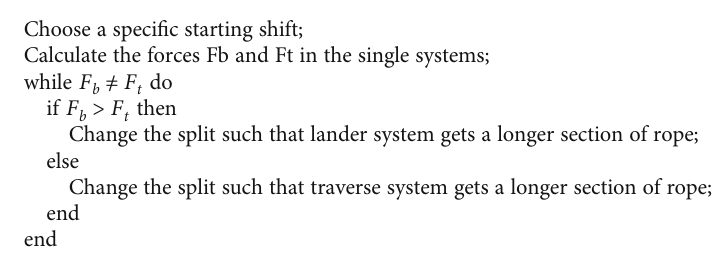
Algorithm 1: Algorithm to choose the correct shift at the